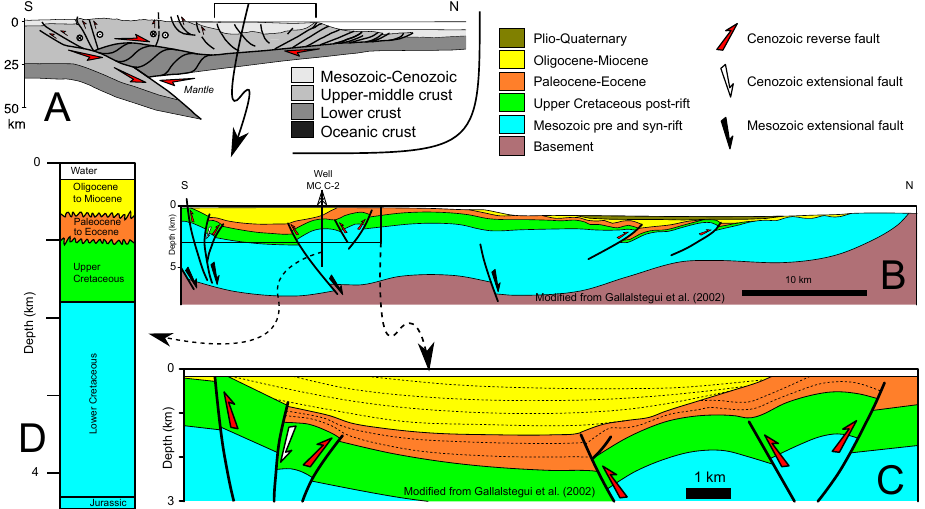
Fig. 21. (A) Crustal-scale geological cross section P3 of Fig. 2 (modified from Gallastegui, 2000 and Quint`a and Tavani, 2012). (B–C) Ge- ological cross section across the Cantabrian platform (modified from Gallastegui et al., 2002). (D) Stratigraphy of well MC C2 (After Gallastegui,